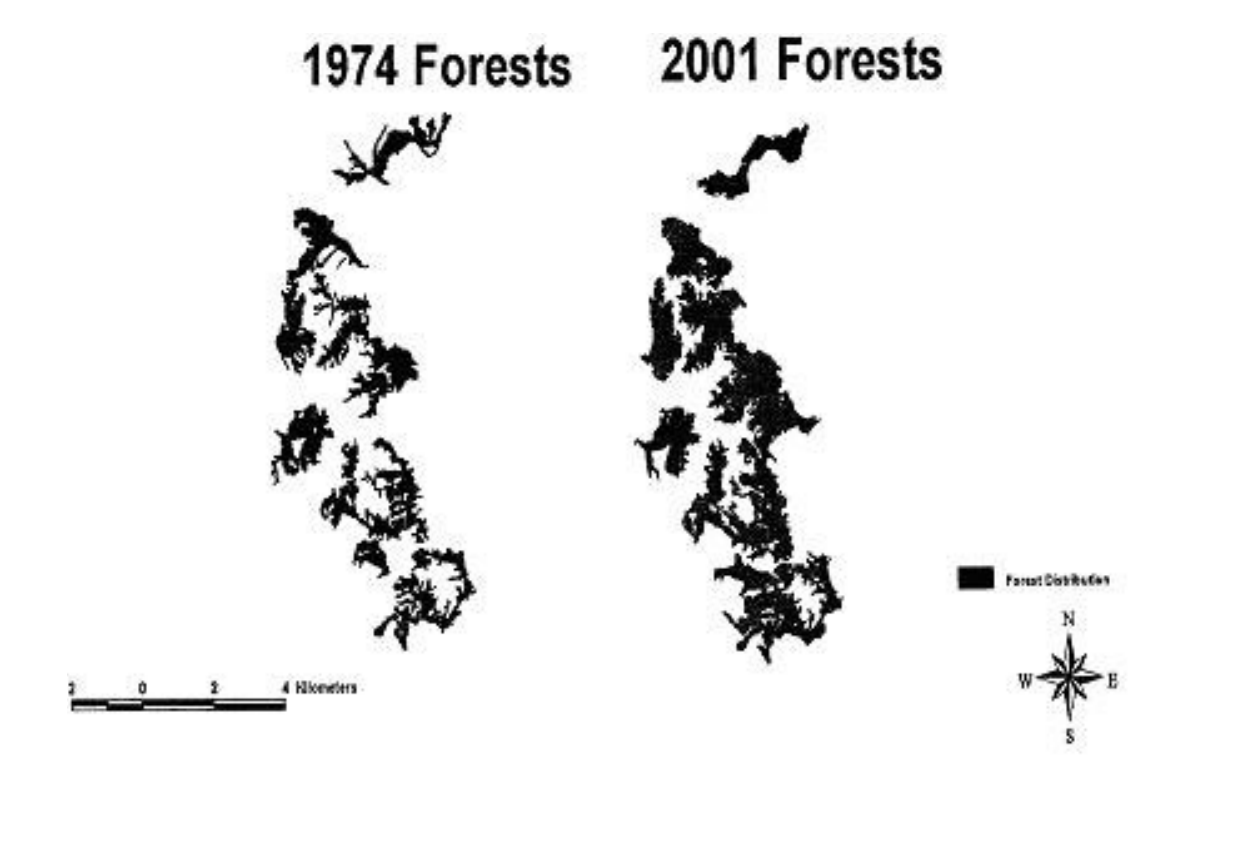
Fig. 2. Sizes of 14 forest patches at Nqabara in 1974 and